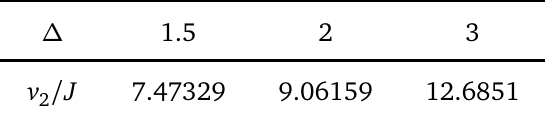
/ J for various anisotropies ∆ according to equation Table 1: Velocity v 2